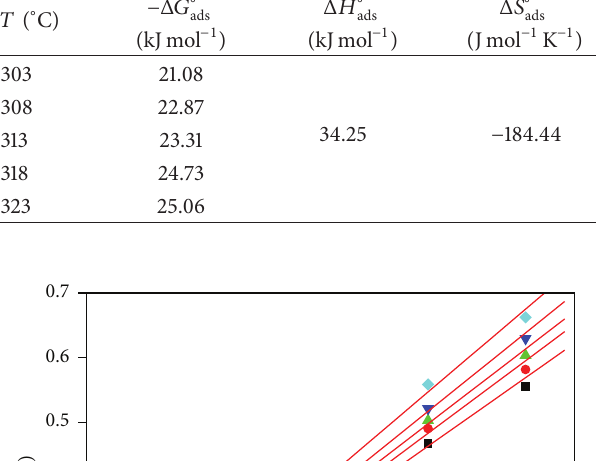
/𝑇) versus 1/ 𝑇 for the corrosion of Figure 8: Plots of ln (𝜐 corr aluminum in 0.5M phosphoric acid containing different concentra- tions of inhibitor (GIE).